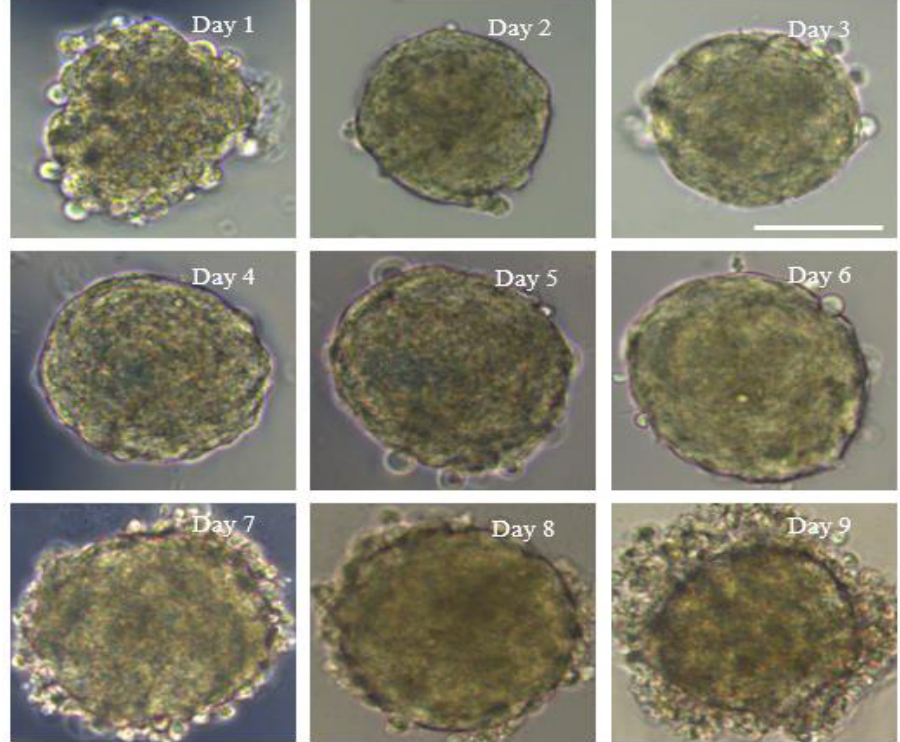
Figure 2. Morphology of multicellular 3D spheroid formation. The numbers on the pictures represent the culture day of the 3D spheroid. On day 1 after cell seeding, 3D spheroid formation occurred. On day 2, the diameter decreased slightly and the spheroid became tight and smooth. On days 3–6, the size of the spheroid gradually became larger. On days 7 and 8, the size displayed no significant change, but cells were observed detached from the edge of the spheroids. On day 9, a large number of cells were detached and the diameter of the spheroids decreased obviously. Magnification = 20×, Bar = 75 µm.